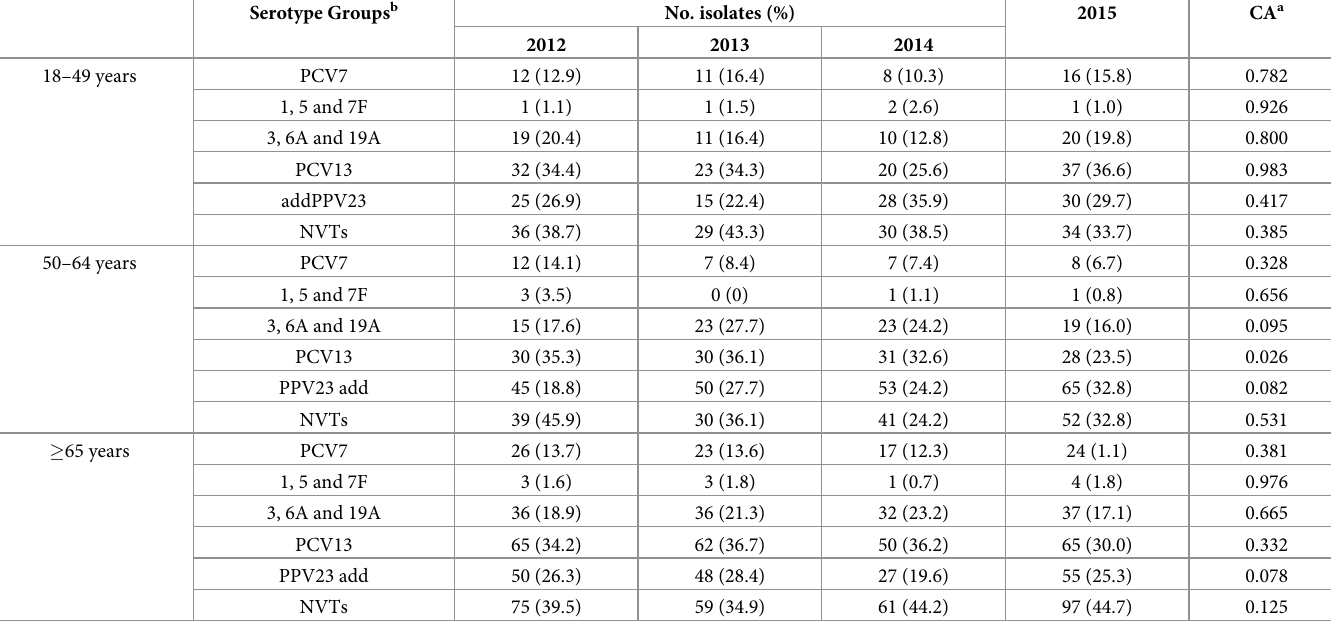
Table 2. Number of isolates responsible for non-invasive pneumococcal pneumonia in adult patients ( � 18 years), according to vaccine serotype groups and age groups,